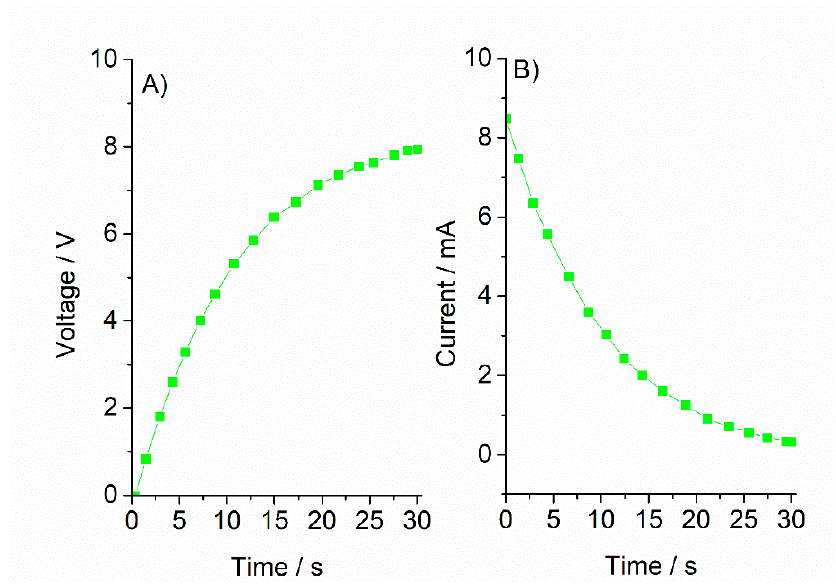
Figure 9. ( A ) Voltage–time transient and ( B ) current–time transient for an integrated photovoltaic- electrochromic system, simulated under STC (1000 Wm − 2 , 25 °C).